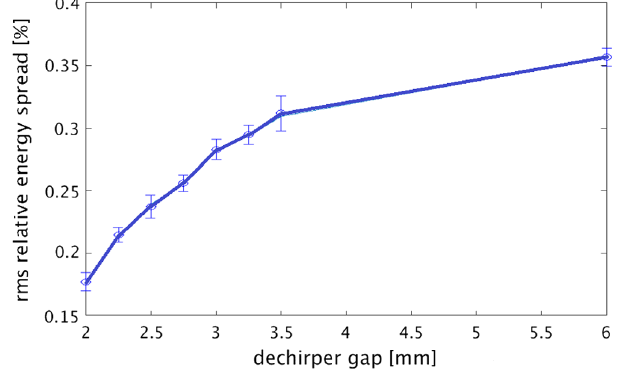
FIG. 6. Projected energy spread as a function of the gap of six dechirper